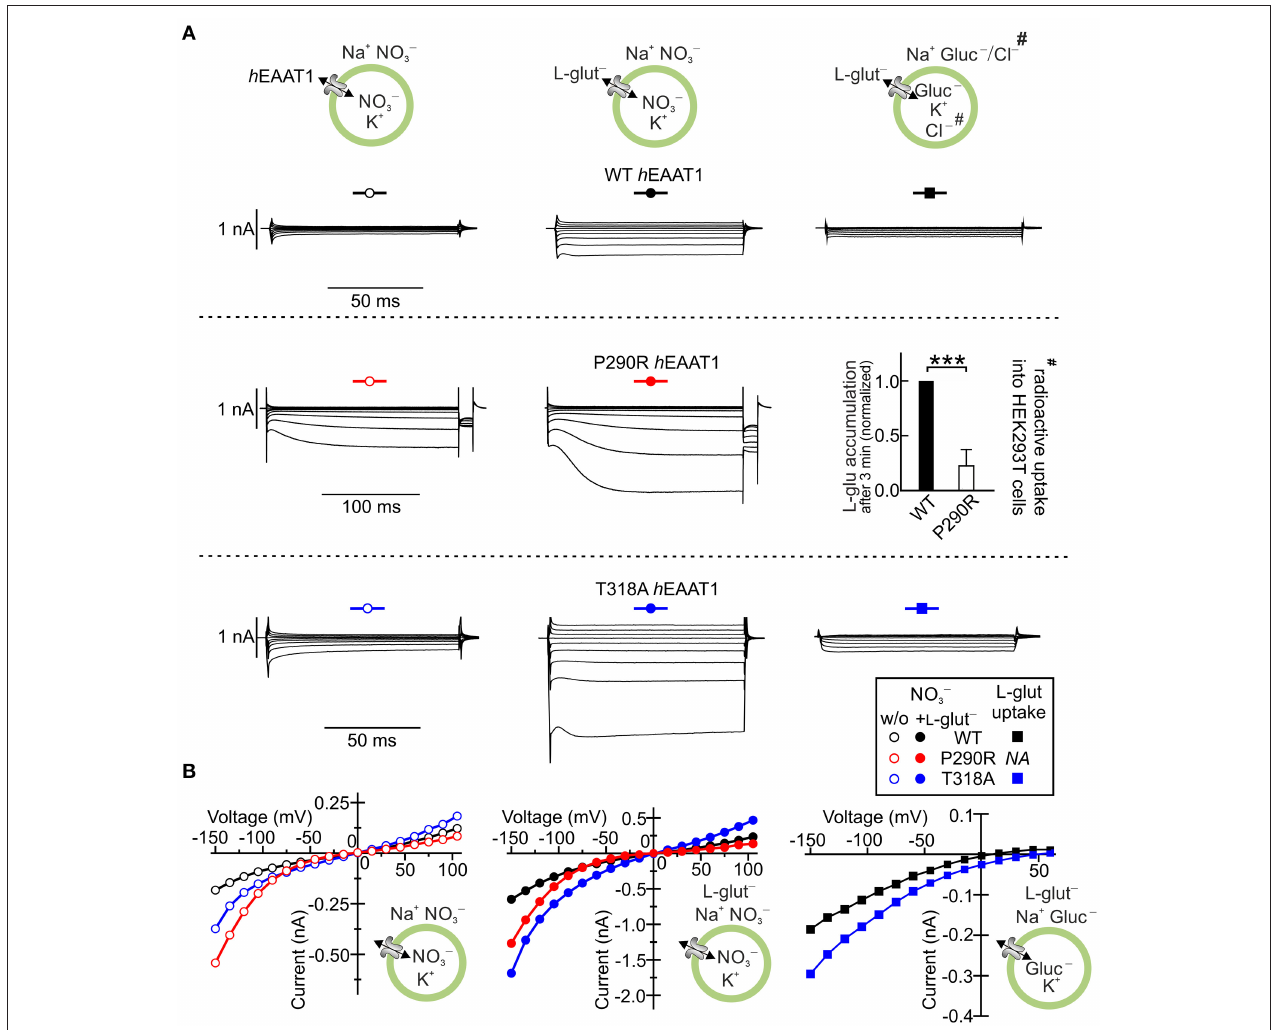
FIGURE 4 | SLC1A3 mutations associated with episodic ataxia 6 modify EAAT1 anion channels. (A) Representative whole-cell current recordings of human wild-type (WT) EAAT1 and episodic ataxia 6-associated EAAT1 variants P290R and T318A heterologously expressed in HEK293T cells in the absence (left) and presence (middle) of external L -glutamate. Representative L-glutamate uptake currents are shown for WT EAAT1 and the variant T318A EAAT1 (right) and the results from radioactive uptake of L- 3 [H]-glutamate # into HEK293T cell lines stably expressing WT EAAT1 and the P290R EAAT1 variant (right). (B) Mean current–voltage relationships from whole-cell recordings of WT and variant EAAT1 proteins, as shown in (A) . h EAAT1: human EAAT1. Level of significance: *** p ≤ 0.001. Reprinted in part from Winter et al. (2012) and Chivukula et al. (2020), with